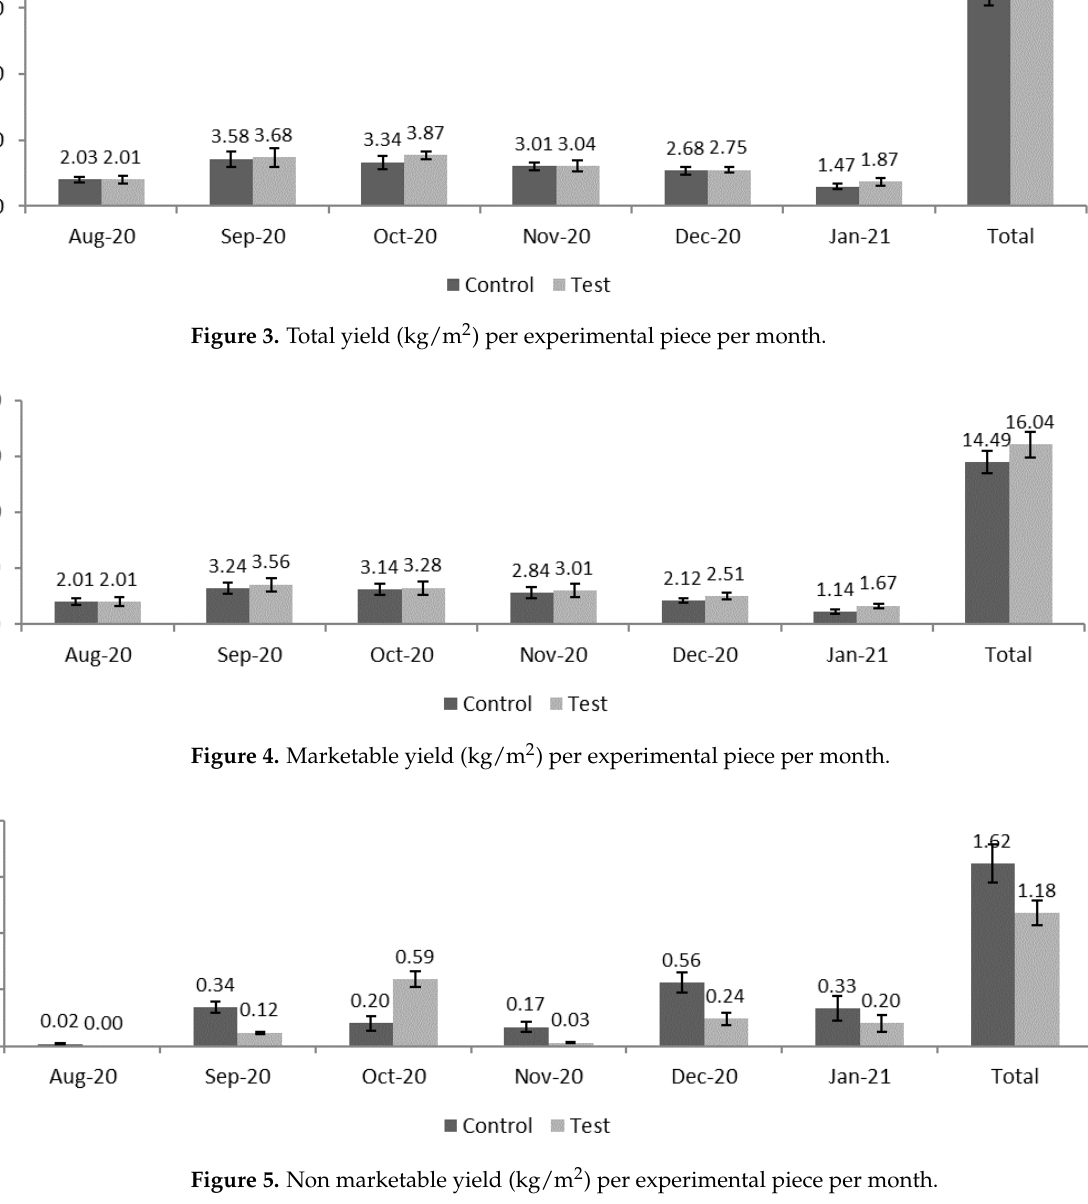
Figure 6. Average catches of mealybugs in chrome-adhesive traps per experimental piece per month. 4. Discussion As can be observed in Figures 3 – 6, the test samples gave better results than the con- trols. More specifically, the test plants proved to be more productive than the control ones with higher total marketable yields. Moreover, a reduced attraction of mealybugs and the presence of larvae on the leaves was observed in the control plants; despite the fact that: a) at the beginning of the experiments, the number of prosperous mealybugs counted both in the control and the test colored sticky traps was the same (14 prosperous/5 traps); (b) the plant protection operations that followed (biological and chemical) in both the control and the test were common; and (c) climatic conditions and hydro-lubrication were com- mon. 5. Conclusions Based on the results of the presented study, it is observed that the innovative poly- meric films with encapsulated alkaloids derived from tomato cultivation by-products as a cover for the stonewool show significant activity towards the pesticide control of the Brioso tomato cultivation. This study served as a model for the practical application of the circular economy and zero pollution crop protection. Author Contributions: Conceptualization, S.P., P.P. and I.T.; methodology, S.P., M.P., P.P. and I.T.; validation, P.P., I.T. and P.S.; formal analysis, M.P.; investigation, S.P., P.P. and I.T.; resources, I.T.; data curation, M.P. and P.P.; writing — original draft preparation, M.P.; writing — review and edit- ing, S.P.; supervision, M.K., I.T. and P.S.; project administration, M.K.; funding acquisition, P.S. and I.T. All authors have read and agreed to the published version of the manuscript. Funding: This research has been co-financed by the ERDF of EU and Greek national funds through the Operational Program Competitiveness, Entrepreneurship, and Innovation, under the special